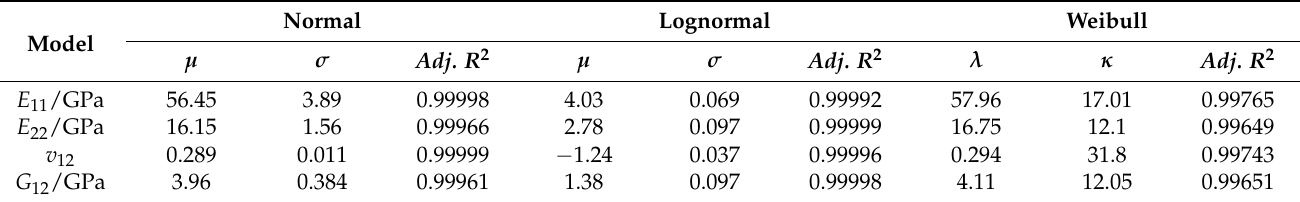
Table 15. Values of the three statistical distribution parameters for the stiffness properties of H-GFRPs under the RTD